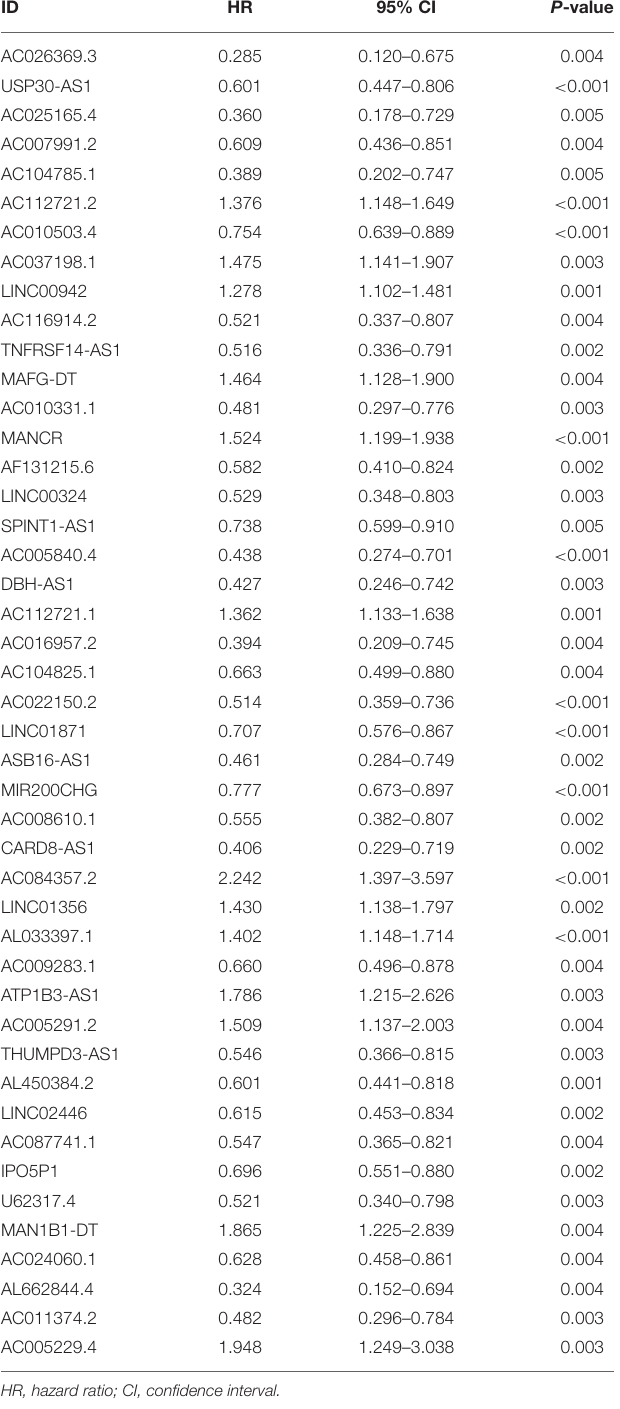
TABLE 1 | Autophagy-related long non-coding RNAs (lncRNAs) ( n = 45) significantly associated with the prognosis of bladder cancer (BC).